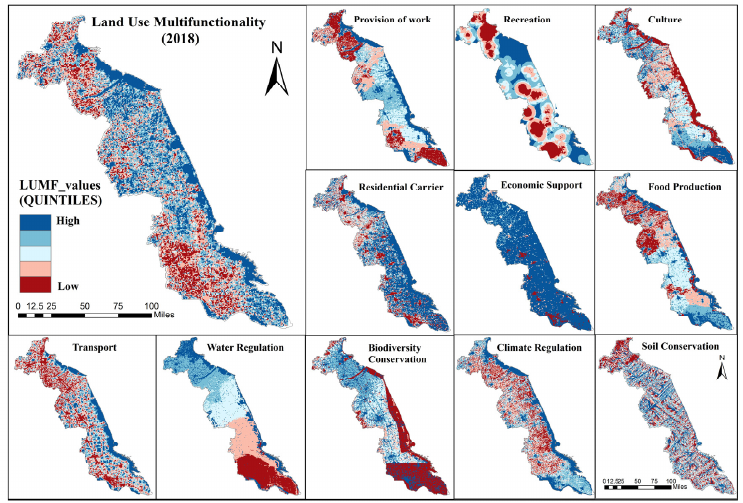
Figure 3. Distribution of 11 LUFs in 2018 by quintiles. Moran’s I index values were calculated in 2000, 2010, and 2018 and showed that the spatial distributions of all LUF indexes were